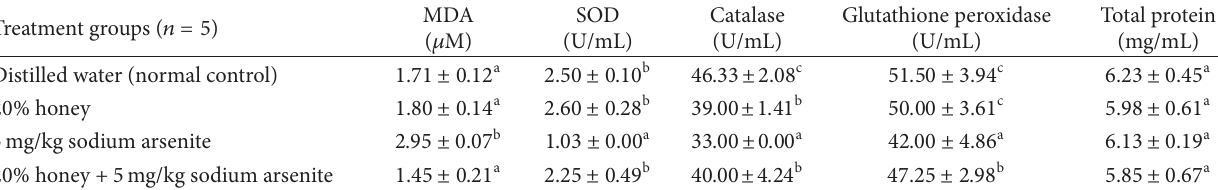
Table 1: Redox sensitive biomarkers level in rat heart tissues due to Acacia honey and sodium arsenite administration. Treatment groups ( 𝑛 = 5 )